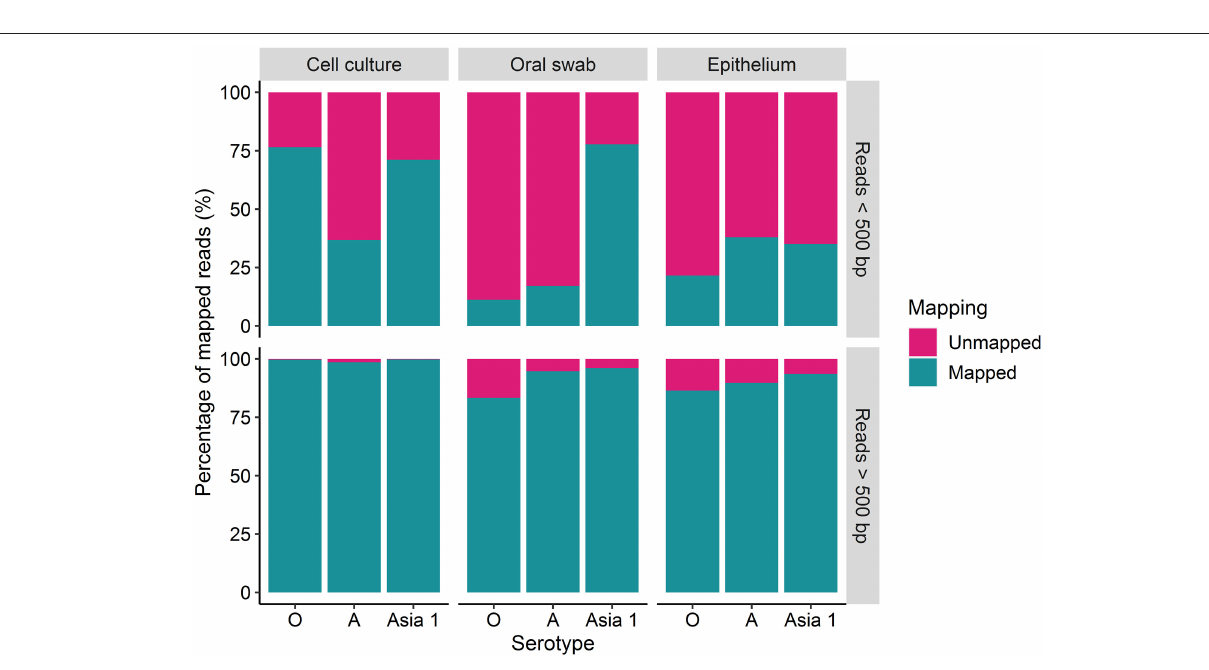
Frontiers in Veterinary Science |